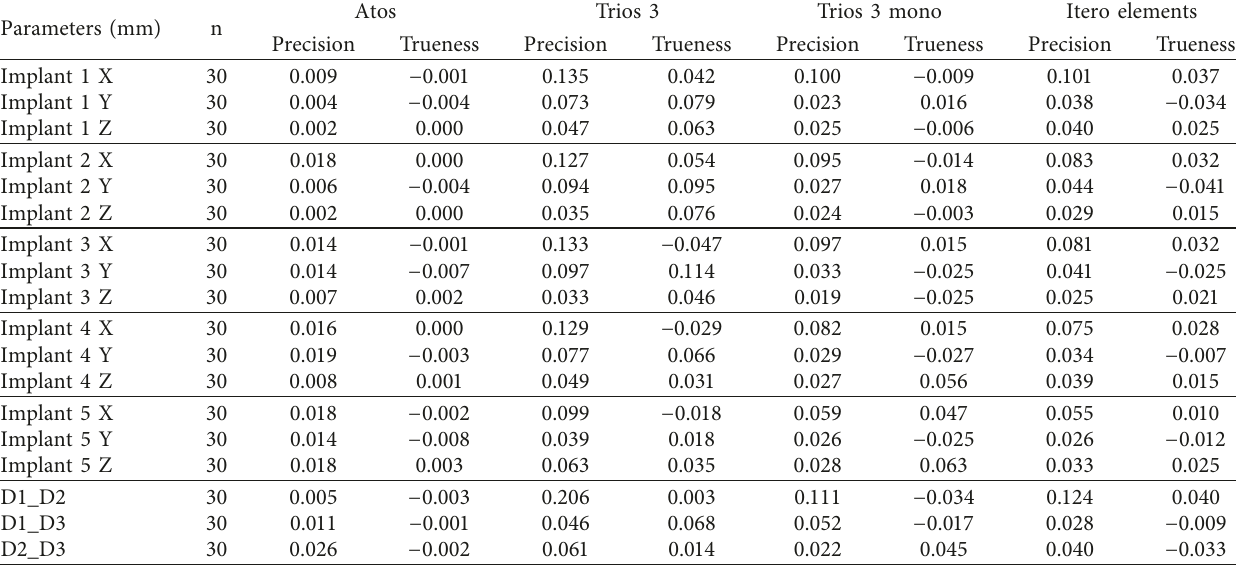
Table 2: Results of precision and trueness of all implants and interarch distances.